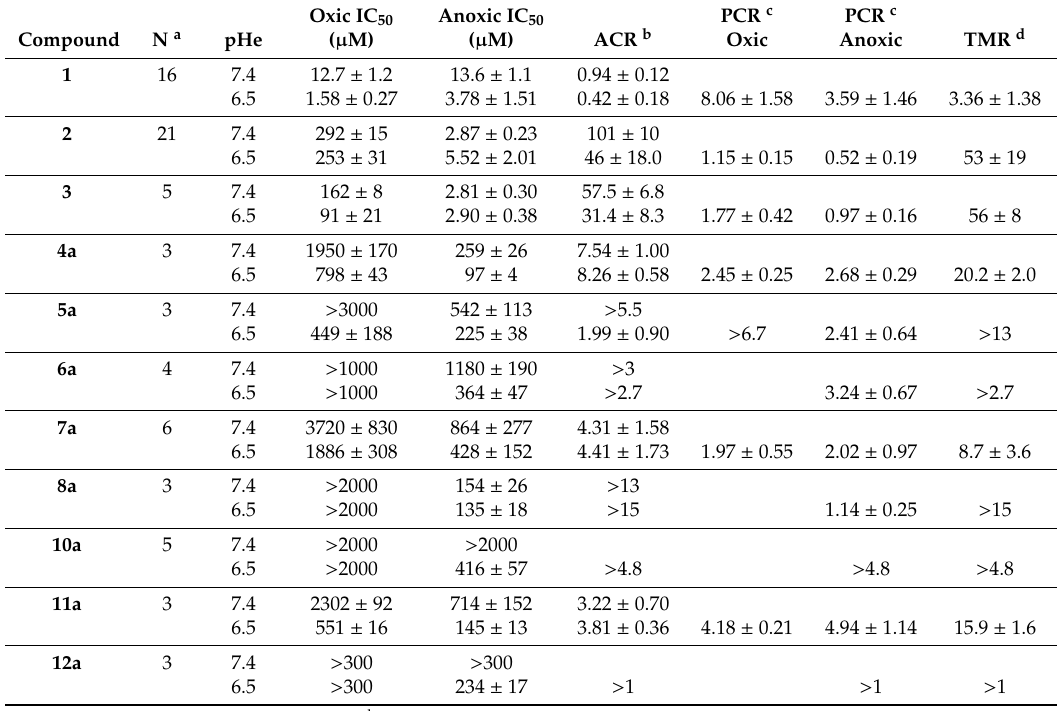
Table 3. Cytotoxicity of BTO acids and reference compounds against SiHa cells by IC 50 assay after 4 h of exposure at pHe 7.4 or 6.5 under oxic or anoxic conditions.